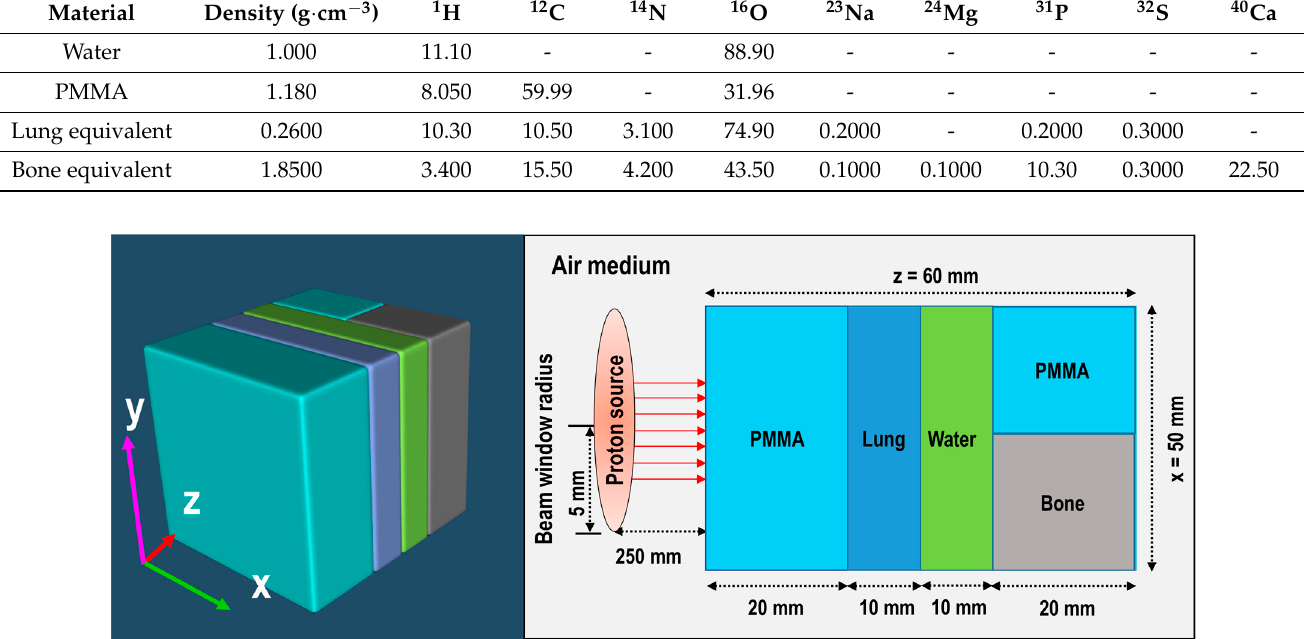
Figure 1. Schematic representation of modelled ordinary slab phantom with dimensions.